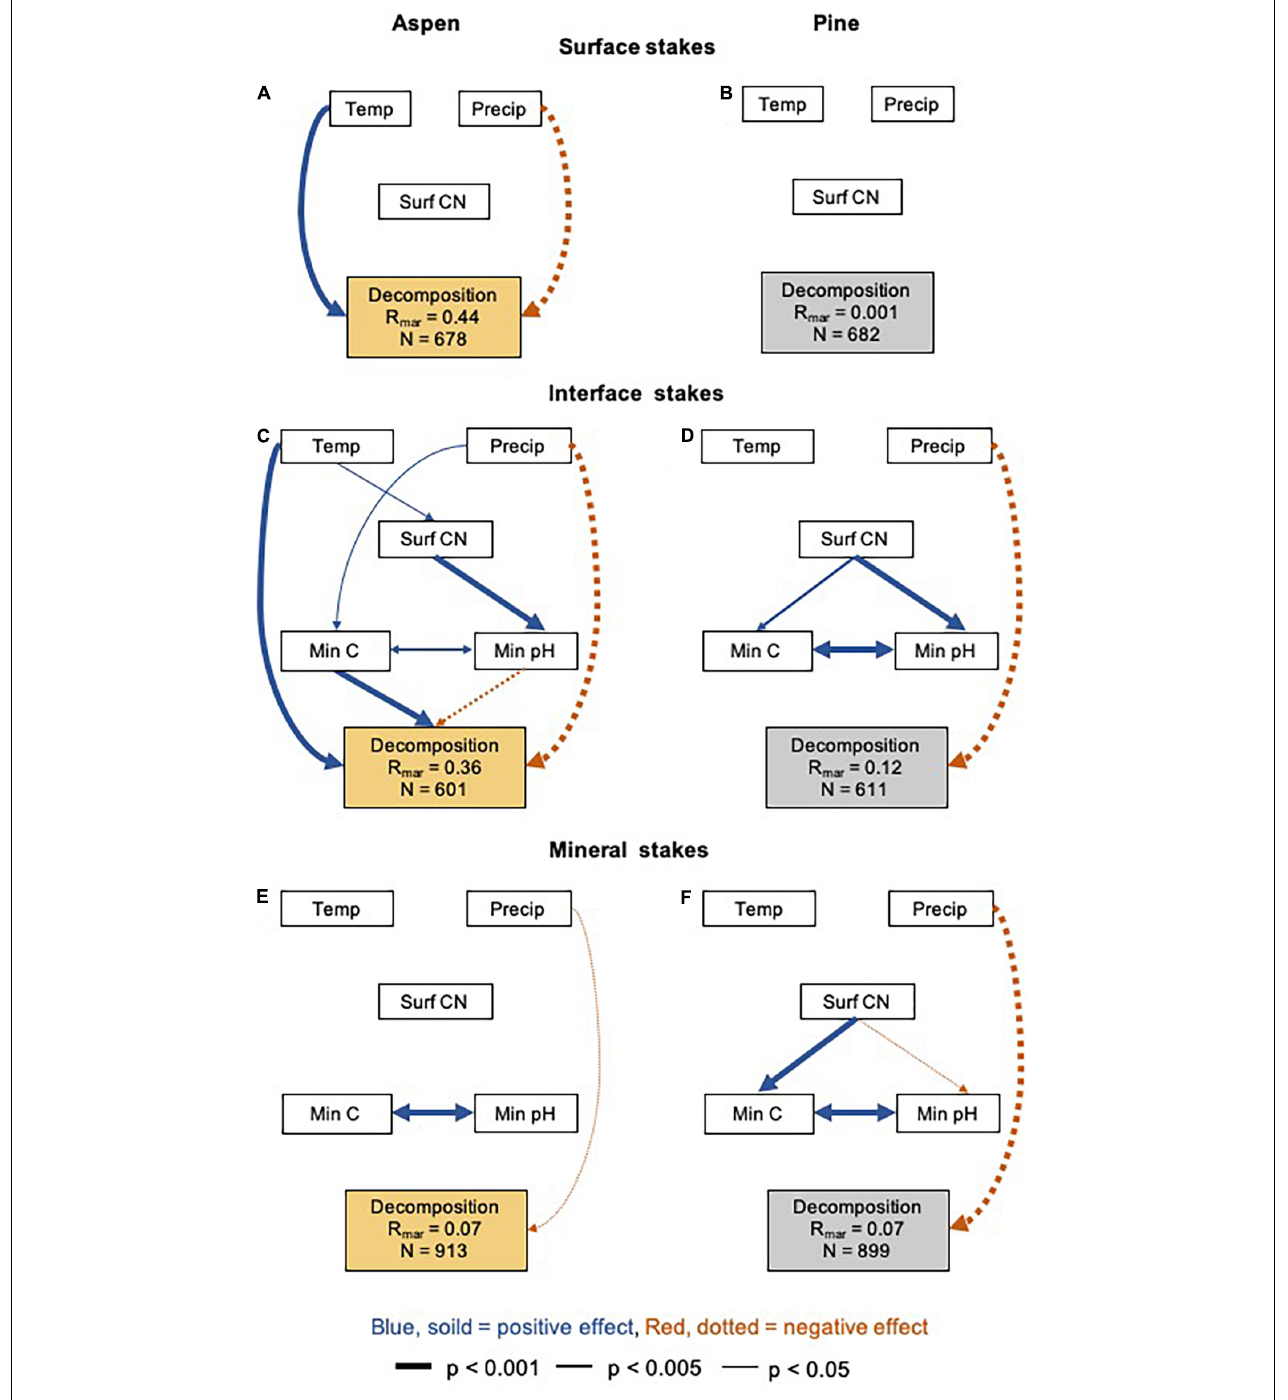
FIGURE 3 | Influence of local environmental conditions on the wood decomposition (mass loss in %) in forested ecosystems. Structural equation model (SEM) diagrams illustrate climatic and soil properties found to affect decomposition of (A) surface aspen stakes, (B) surface pine stakes, (C) interface aspen stakes, (D) interface pine stakes, (E) mineral aspen stakes, (F) mineral pine stakes. Blue, solid lines represent positive relationships, red, dashed lines negative relationships. Line width corresponds to differences in significance levels (thick = p < 0.001, medium = p < 0.005, thin = p < 0.05). Non-significant connections were removed. Temp, average air temperature per site for the individual incubation time per wood stake; Precip, average precipitation per site for the individual incubation time per wood stake; Surf CN, surface organic horizon C:N ratio; Min C, mineral soil C concentration; Min pH, mineral soil pH. Decomposition values were log-transformed. Total number of sites included for surface aspen and pine = 19, interface aspen and pine = 10, mineral soil aspen and pine = 23. For alternative models see Supplementary Figures 7–10 .